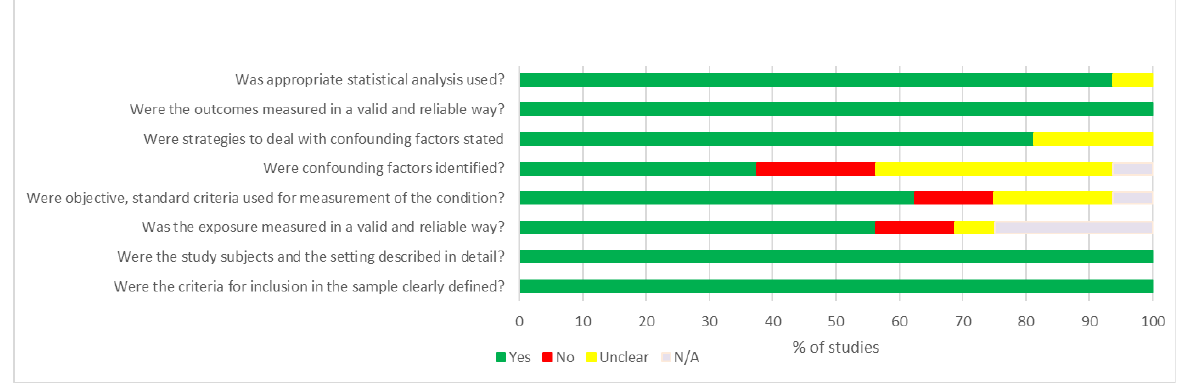
Figure 2. Items of JBI Critical Appraisal Checklist of included studies. Table 3. Results of the quality assessment of included studies according to the JBI Checklist.